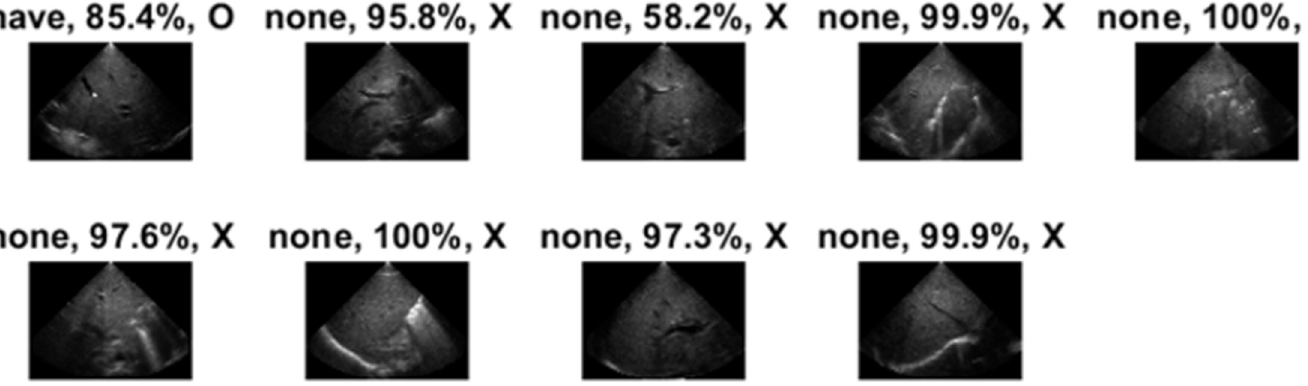
Fig 4. The detailed identification results of the “Have02” patient with BA. The first box above the image represents the prediction by the network model. The “have” and the “none” means BA was predicted and the non-BA, respectively. The second box represents the probability of the prediction. Meanwhile, the third box represents whether or not the judgment was correct (O is correct and X is